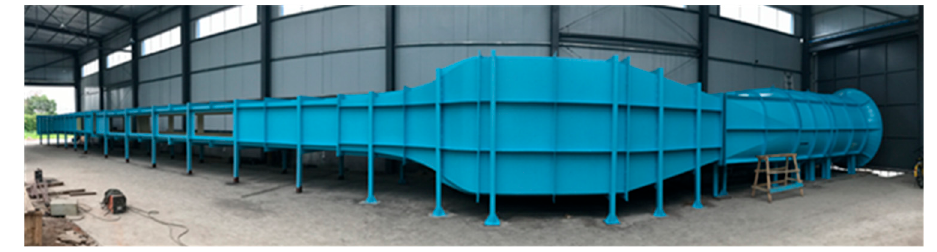
Figure 2. Wind tunnel laboratory.